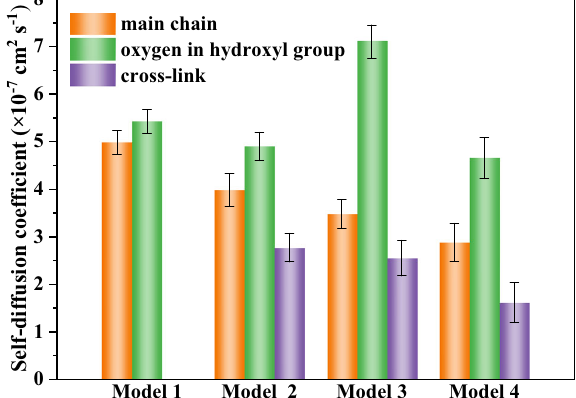
Fig. 2 Self-diffusion coef fi cients of the main chain, oxygen of hydroxyl group, and cross-link point in the unaged and aged nano-silica/PDMS models. The error bars stand for the standard deviations from fi ve independent sample.